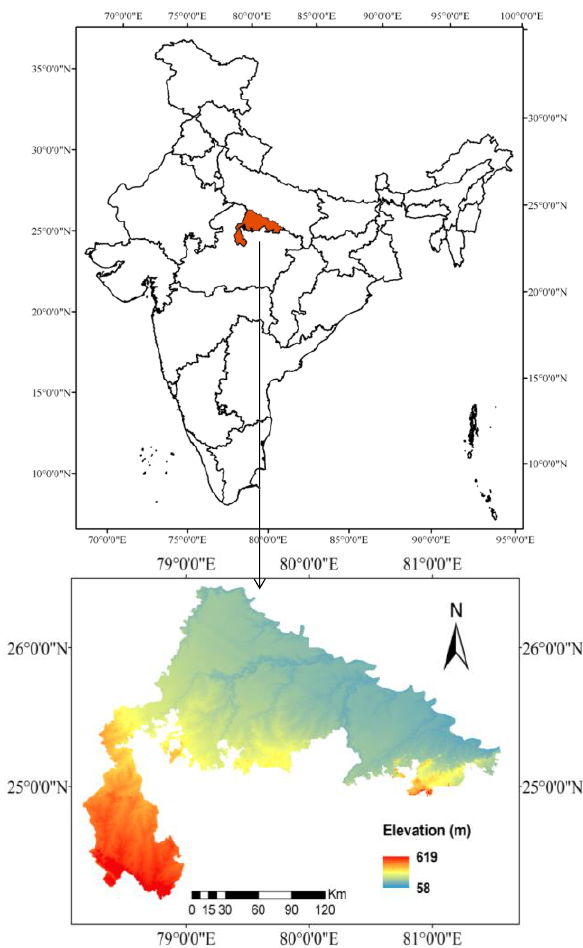
Figure 1. Study area map with Digital Elevation